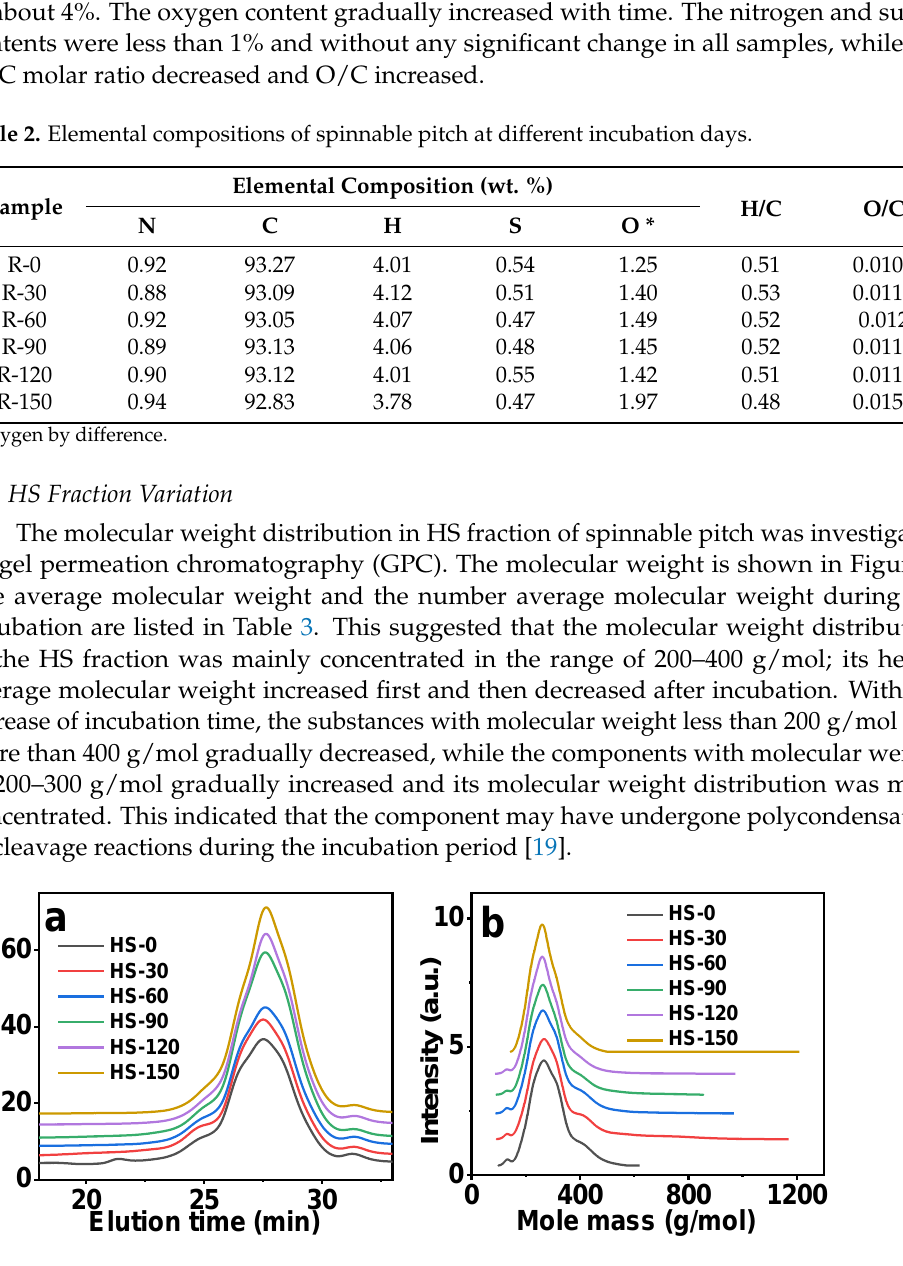
Figure 2. GPC spectra ( a ) and molecular weights ( b ) of HS fractions at different incubation times.